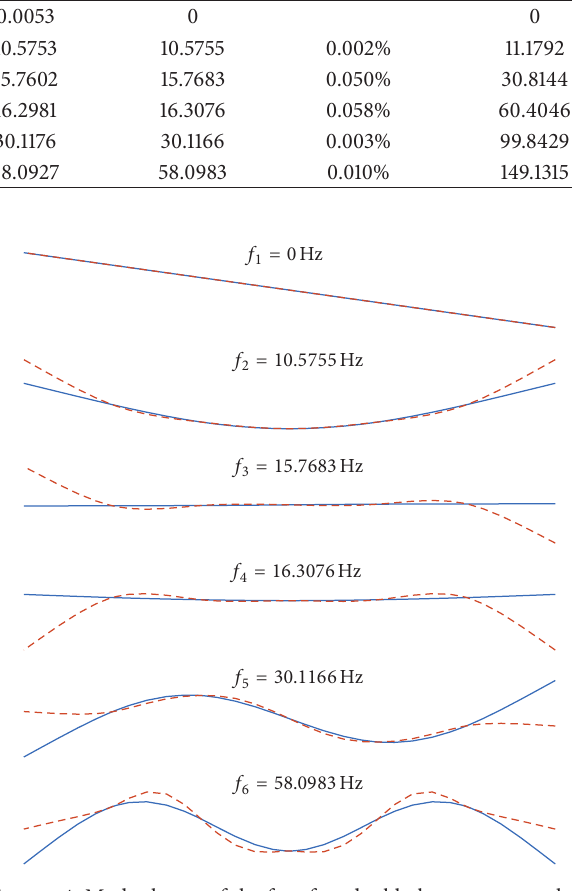
Figure 4: Mode shapes of the free-free double-beam system when using 5